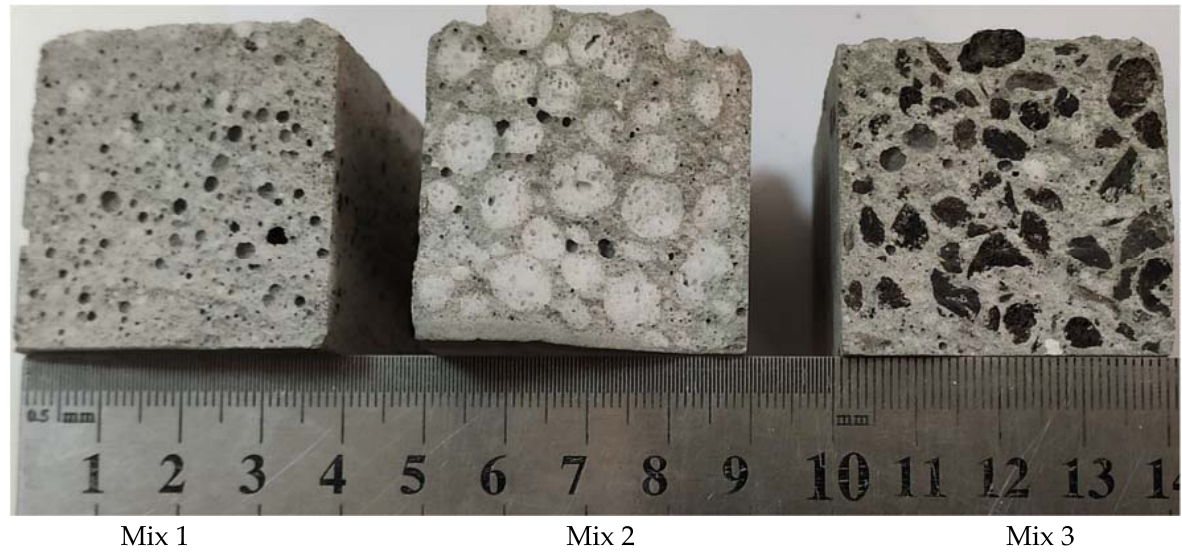
Figure 6. The macrostructure of the lightweight aggregate shotcrete samples.